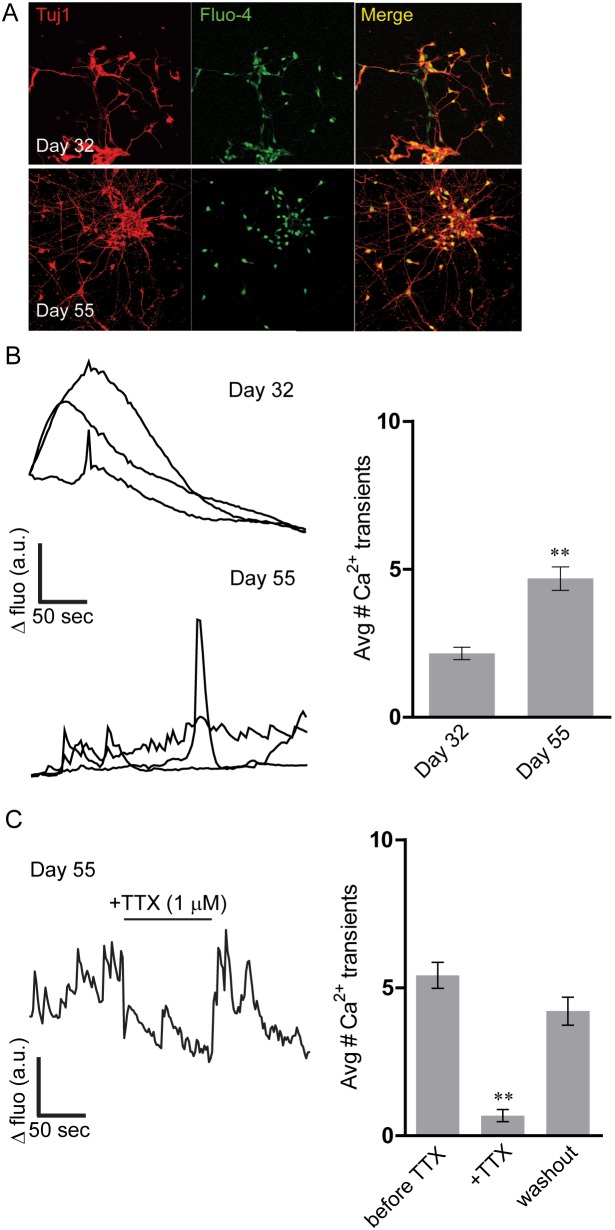
Spontaneous calcium transients increase in iPSC-derived neurons during development.A) After imaging of spontaneous Ca2+- transients iPSC-derived neurons were fixed and stained for Tuj1 at day 32 and day 55, revealing more complex morphology at day 55 (scale bar = 40 µm). B) Representative Fluo-4 spontaneous Ca2+- transients from 3 iPSC-derived neurons at day 32 and at day 55 (ΔFluo = ΔFluorescence; a.u. = arbitrary unit). Neurons exhibit slow broad transients, consistent with early developing neurons at day 32. By day 55, calcium transients take on a more spike-like morphology reflecting what has been reported for maturing neurons. Group data demonstrates that iPSC-derived neurons exhibit a significant increase in calcium transients at day 55 as compared to day 32 (n = 113 neurons/10 coverslips for both groups, p<0.001 comparing day 32 with day 55). C) The average number of Ca2+ transients at day 55 was dramatically reduced following perfusion with 1 µM TTX with recovery following washout of the toxin (n = 20/3 coverslips, p<0.001 compared with average number of Ca2+ transients prior to TTX perfusion). A sample trace derived from a representative experiment is shown on the left).